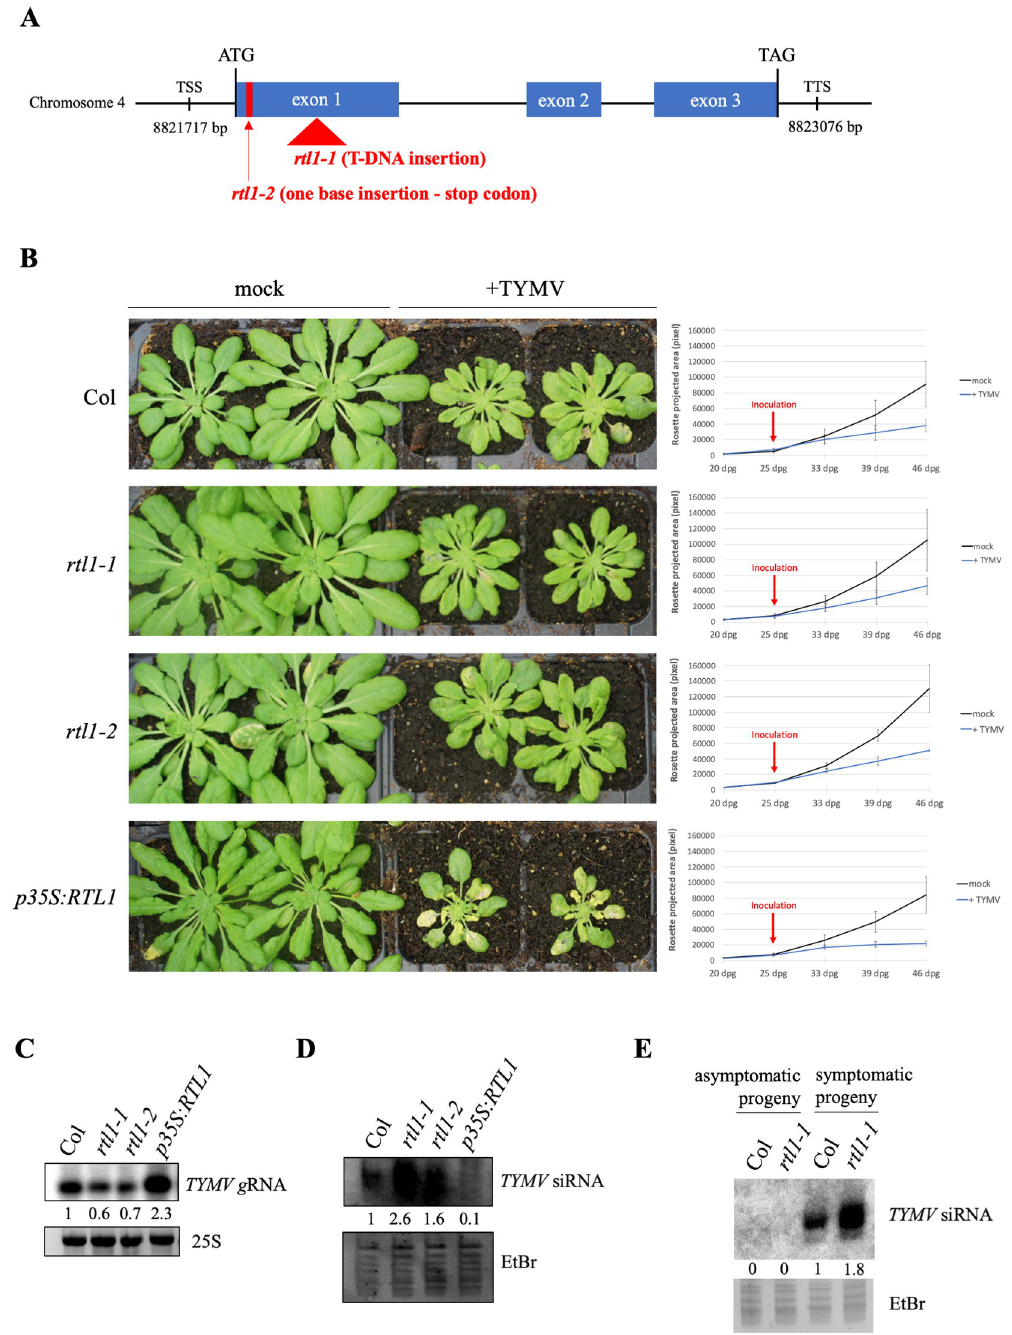
Fig 6. RTL1 favors TYMV infection by counteracting anti-viral PTGS. A) Scheme of the RTL1 gene with its coordinates on chromosome 4. The location of the rtl1-1 mutation (T-DNA insertion SAILseq_337_F04.1) and of the rtl1-2 mutation (CRISPR-induced one-base insertion) are indicated. TSS: Transcription Start Site, TTS: Transcription Termination Site. B) Pictures of wild type, rtl1-1 and rtl1-2 mutants and p35S : RTL1 plants three weeks after infection with TYMV. Plants were grown under short day conditions. The growth curves show the temporal change of rosette area (averaged by four plants, +/-SE) in mock- and TYMV-infected plants from one week pre-inoculation to three weeks post-inoculation. dpg: days post- germination. C) TYMV full-length genomic RNA (gRNA) accumulation in Arabidopsis thaliana wild type, rtl1-1 and rtl1-2 mutants and p35S : RTL1 plants four weeks after infection with TYMV. Total RNA was extracted from a pool of 16 infected plants per genotype, run onto an agarose gel and hybridized with a TYMV probe. Data are normalized to Col. D) TYMV siRNA accumulation in Arabidopsis thaliana wild type, rtl1-1 and rtl1-2 mutants and p35S : RTL1 plants four weeks after